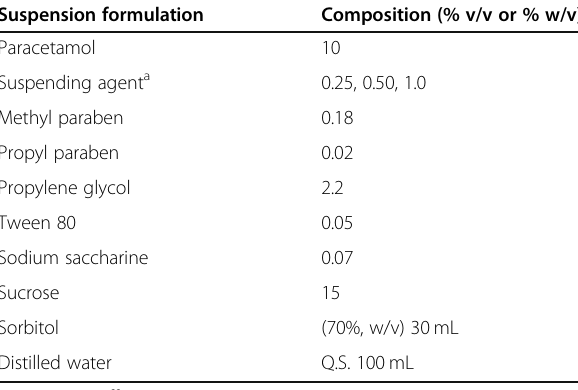
Table 2 Compositions of paracetamol suspension formulations Suspension